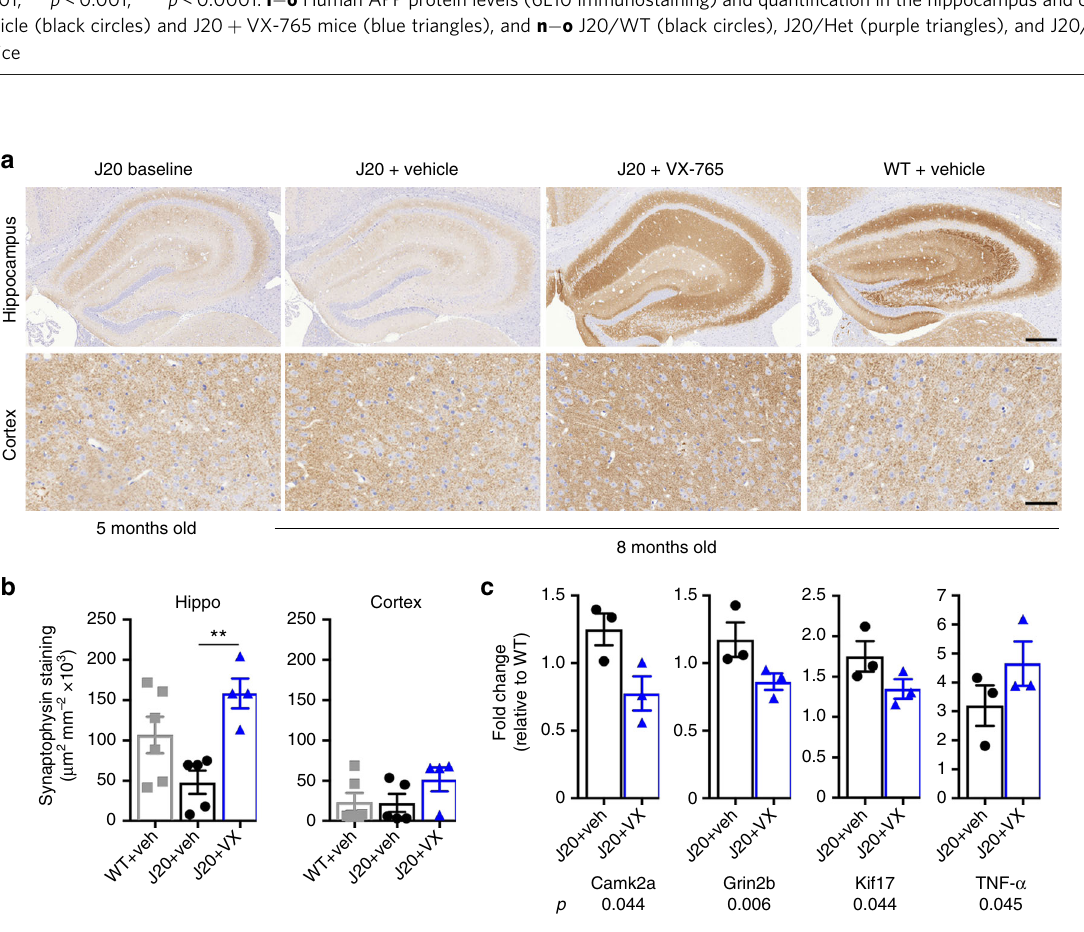
Fig. 5 VX-765 prevents progressive A β accumulation in J20 mice. a A β micrographs of hippocampal SLM and S1 cortex (scale bar = 50 µ m). b Quantitative analysis comparing A β immunostaining density between J20 + vehicle (black circles) and J20 + VX-765 (blue triangles) mice in the CA1 hippocampal pyramidal cell layer to the SLM ( p = 0.0029) and cortex ( p = 0.0314, unpaired t test). c Quantitative analysis comparing A β immunostaining density between J20 − / + / Casp1 + / + J20/WT (black circles) and J20 − / + / Casp1 − / − J20/KO (blue triangles) mice in the CA1 hippocampal cell layer ( p = 0.0040) and cortex (0.0276, unpaired t test). d − g RIPA- ( d , e ) and formic acid- ( f , g ) soluble A β levels in the hippocampus and cortex of 5-month baseline J20 − / + (black diamonds), J20 + vehicle (black circles), and J20 + VX-765 (blue triangles) mice. d , f A β 42 /A β 38 + A β 40 + A β 42 levels (RIPA soluble, hippo: F(2,17) = 27.85, p < 0.0001) and e , g total A β ANOVA, Dunnett ’ s post-hoc versus J20 + vehicle, *** p < 0.001, **** p < 0.0001. h − k J20 − / + / Casp1 + / + J20/WT (black circles), J20 − / + / Casp1 − / + J20/Het (purple triangles), and J20 − / + / Casp1 − / − J20/KO (blue triangles) RIPA- ( h , i ) and formic acid- ( j , k ) soluble A β levels in the hippocampus and cortex of J20/WT, J20/ Casp1 + / − (J20/Het), and J20/ Casp1 − / − J20/KO mice. h , j A β 42 /A β 38 + A β 40 + A β 42 levels (RIPA- soluble, hippo: F(2,26) = 16.03, p < 0.0001; RIPA-soluble, cortex: F(2,26) = 6.602, p < 0.0048) and i , k total A β ANOVA, Dunnett ’ s post-hoc versus J20/